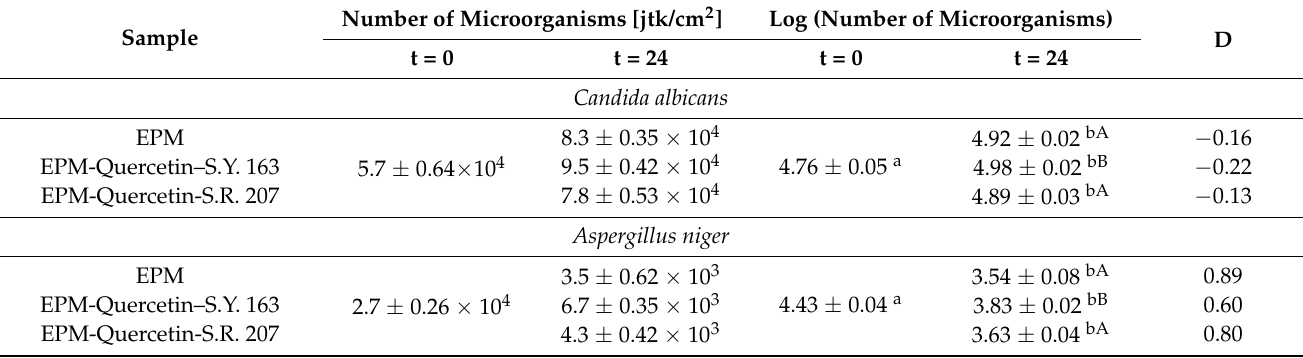
Table 3. Fungistatic activity of the chosen EPM composites containing a combination of synthetic and natural colorants. The values in the table are the average of three measurements (a, b—differences between t = 0 and t = 24; A, B—differences in time of 24 h between